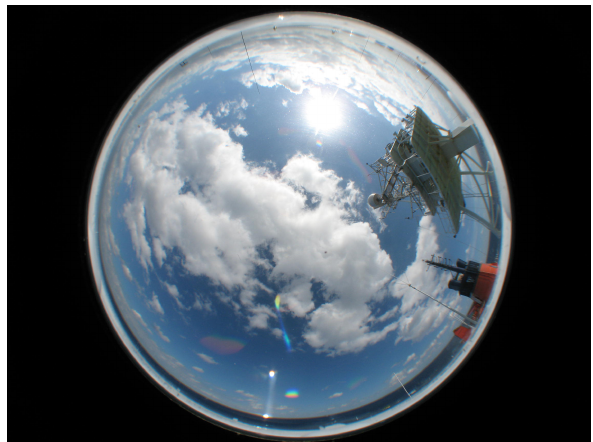
Fig. 1. All-sky image example used for training (2 November 2007, 12:48 UTC).